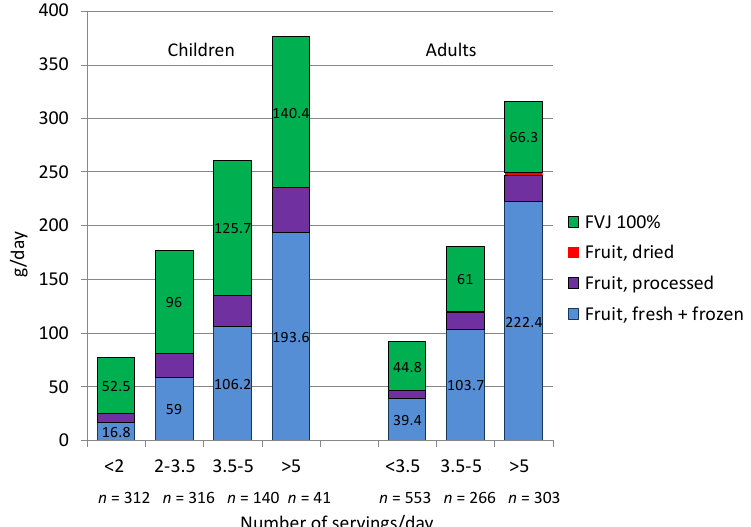
Figure 4. Contribution of fruit and FVJ (fruit and vegetable juices) to total fruit intakes by PNNS (Programme National Nutrition Santé) level of consumption.